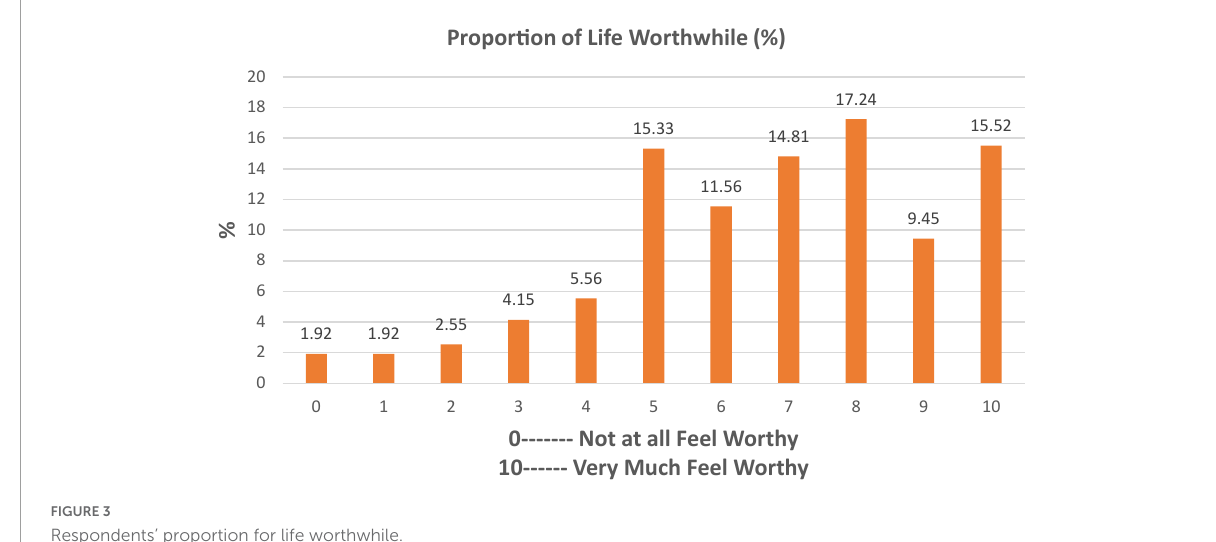
FIGURE3 Respondents’ proportion for life